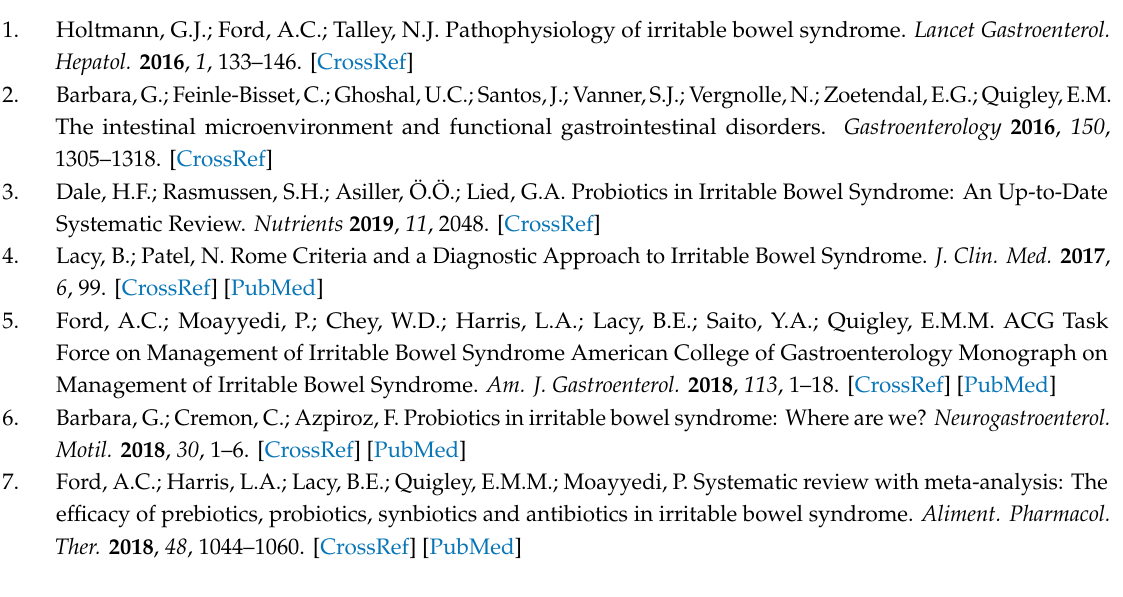
Table S1: Daily stool frequency over intervention period Table S2: IBS quality of life and perceived stress scores over intervention period; Table S3: Study product tolerability and compliance over intervention period; Table S4: Safety variables over intervention